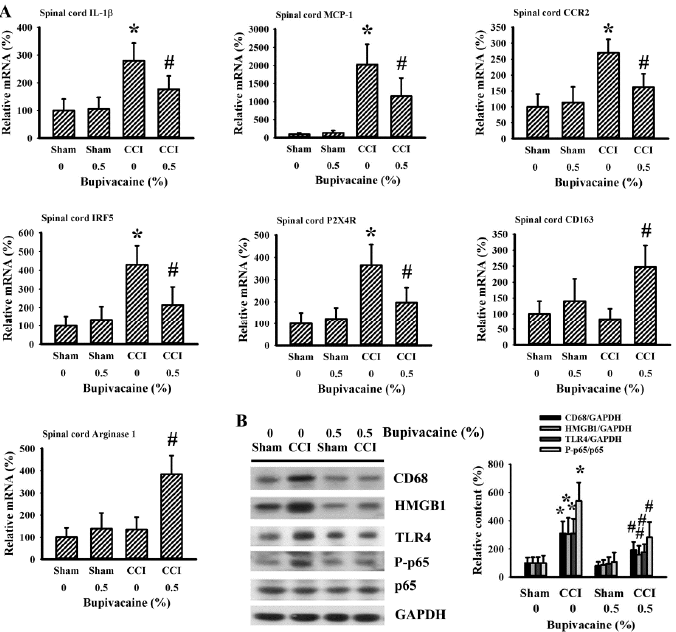
Figure 3. Bupivacaine alleviated inflammatory responses in the spinal cords of CCI rats. Rats were intrathecally injected with the indicated concentrations of bupivacaine (0 and 0.5%, diluted in saline) for 30 min prior to being subjected to sham and CCI operation. Seven days later, ipsilateral spinal cord dorsal horns (L4–L6) were collected and subjected to quantitative RT-PCR for the measurement of IL-1 β , MCP-1, CCR2, IRF5, P2X4R, CD163, and arginase 1 mRNA expression ( A ). Protein content of CD68, HMGB1, TLR4, P-p65, p65, and GAPDH was measured in the ipsilateral spinal cord dorsal horns (L4–L6) using Western blotting. Representative blots and quantitative results are shown ( B ). * p < 0.05 vs. sham/saline group and # p < 0.05 vs. CCI/saline group, n =